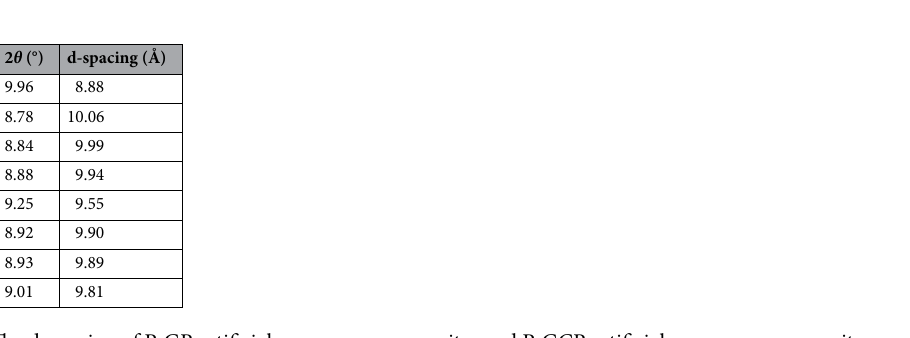
Table 1. The d-spacing of P-GP artificial nacre nanocomposites and P-GCP artificial nacre nanocomposites.